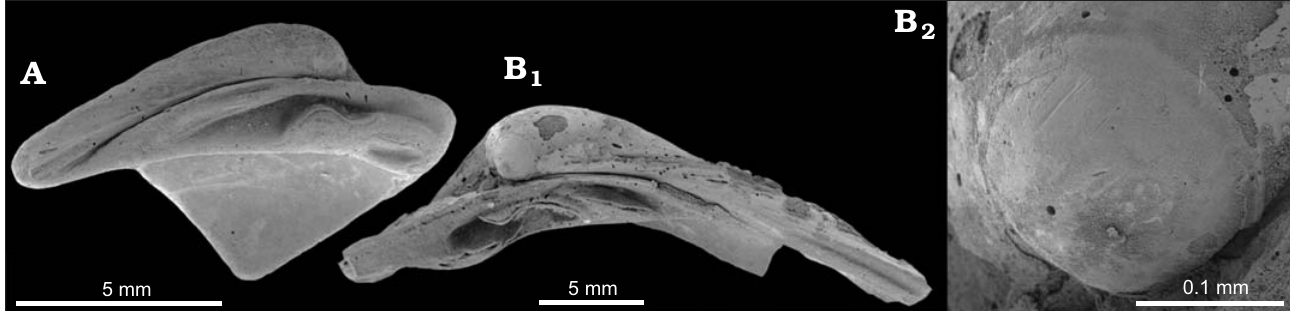
Fig. 10. The vesicomyid bivalve Isorropodon sp. from the late Pliocene of Italy, Stirone River seep deposit. A . MGGC.22019, hinge area of left valve. B . MGGC.22020, hinge area of right valve (B 1 ), close-up of prodissoconch (B 2